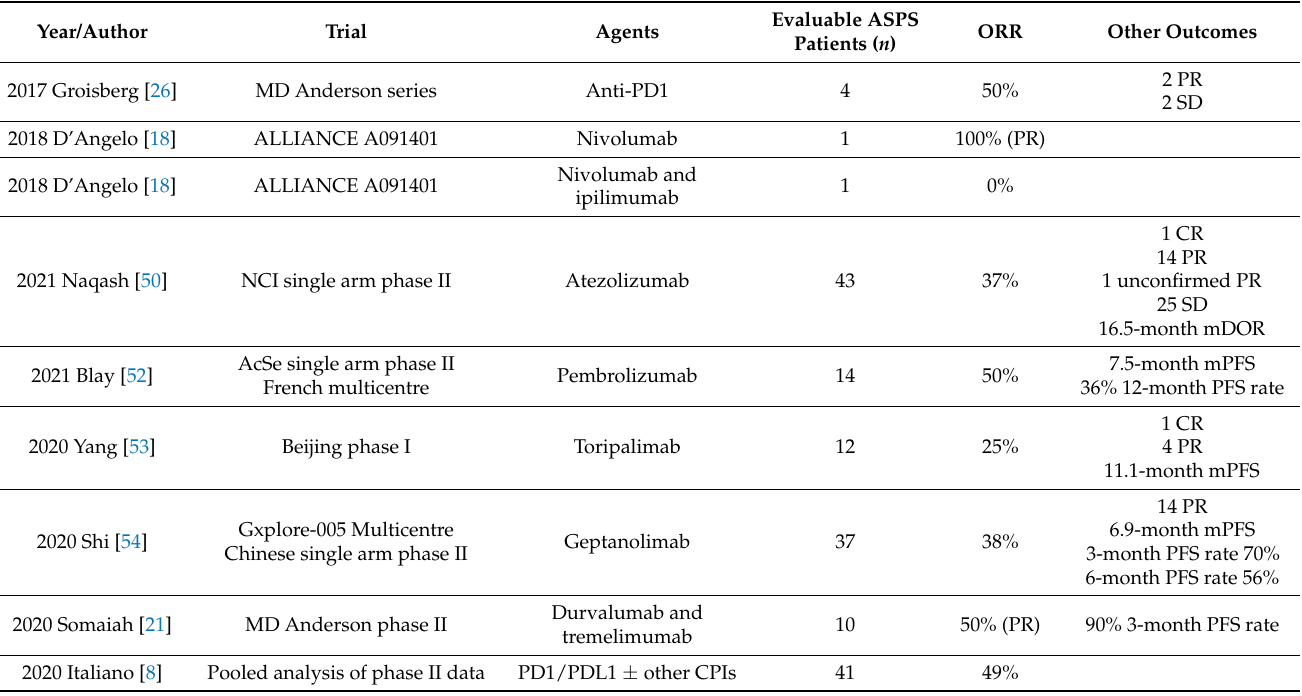
Table 2. Clinical trials exploring the use of CPIs in